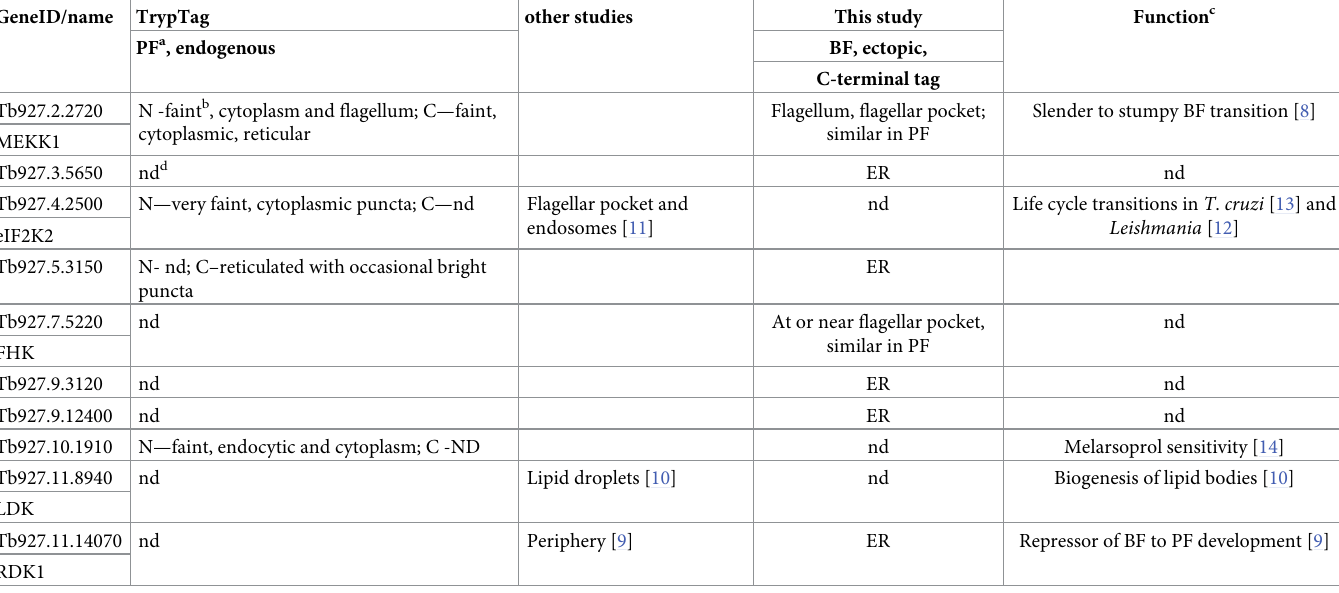
Table 1. Summary of localization studies and